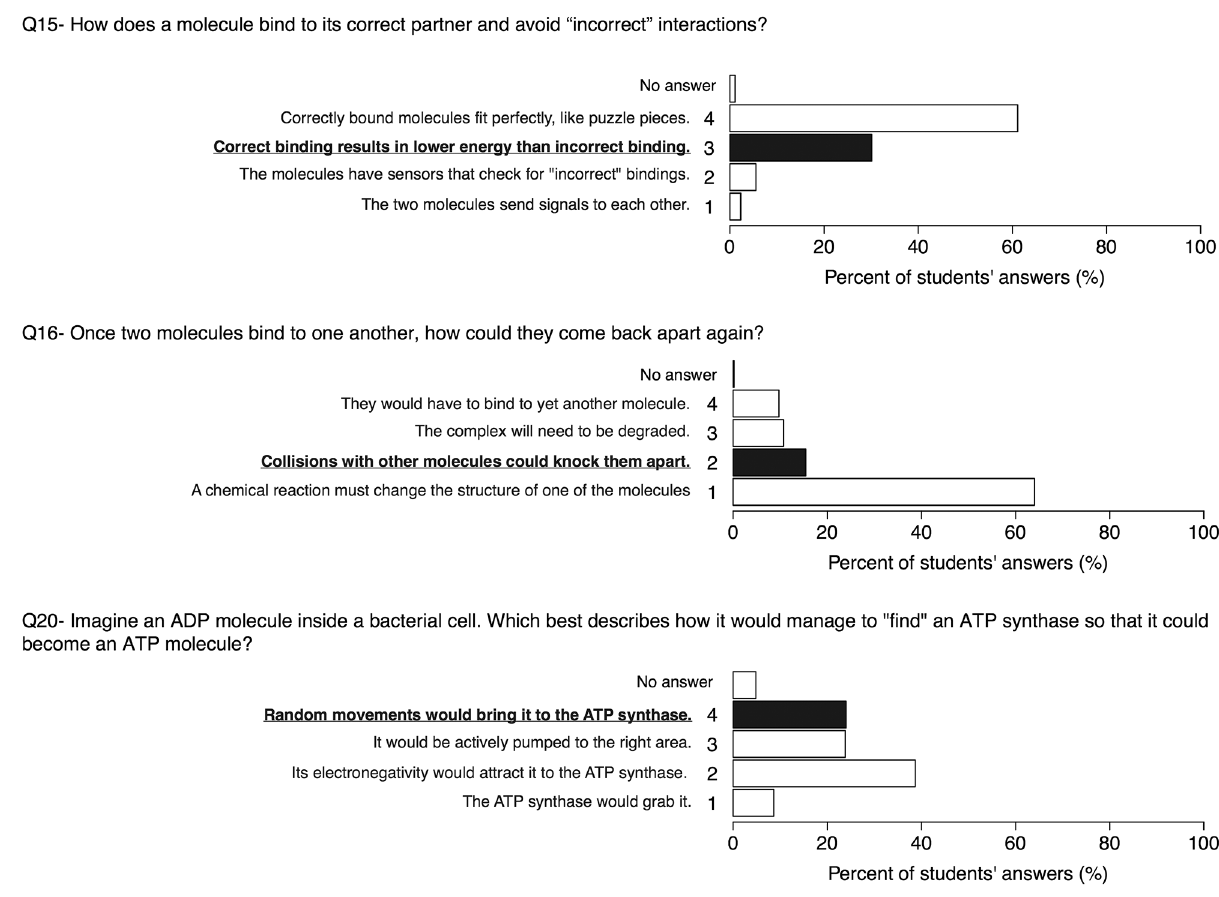
Fig 4. Results on questions 15, 16 and 20. Many participantswere attracted by the oversimplifying analogyof puzzle pieces to explain molecularinteractions and underestimated random diffusionand collisionsas the main influenceto spreadand separate associated